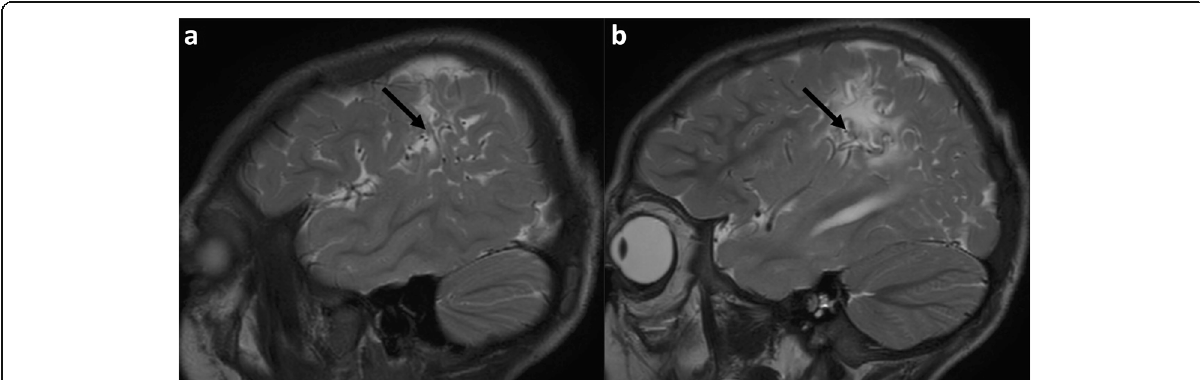
Fig. 4 a , b Isolated peri-Sylvian watershed involvement in a 12-year-old girl. Sequential T2-weighted MRI slices in the sagittal plane demonstrate atrophy of the cortex and subcortical signal abnormality with white matter volume loss, at the most superior portion of the Sylvian fissure (black arrows), which represents an ‘ end-zone ’ of all three major cerebral arteries and represents the most commonly involved portion of the watershed zone in patients sustaining partial-prolonged HII at term gestation